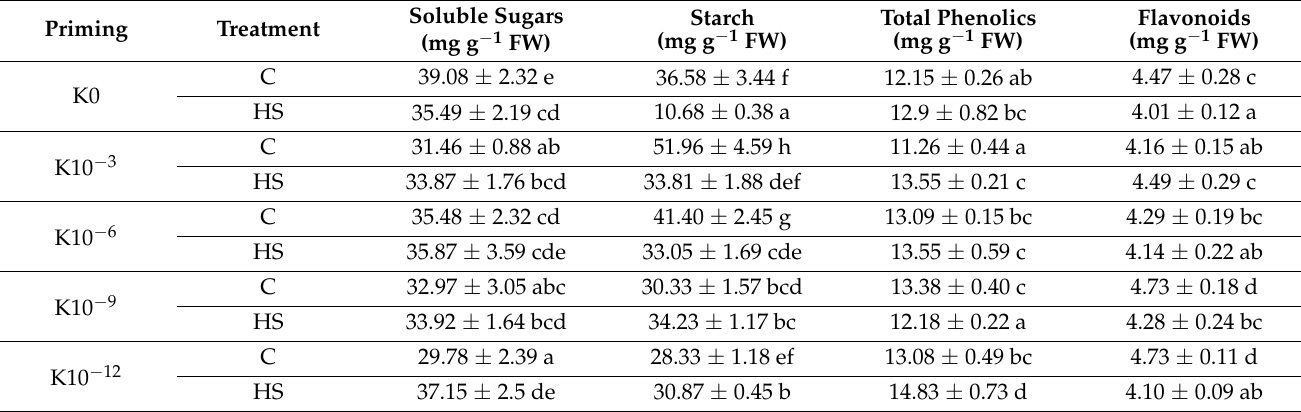
Figure 2. Photosynthetic pigments ( A ), free L-Pro content ( B ), and MDA ( C ) in soil-grown maize plants subjected to heat waves with or without biostimulant treatment (application via foliar spray of 10 − 3 , 10 − 6 , 10 − 9 , and 10 − 12 Kaishi solution). Values are means of three biological repeats ( n = 3) ± SD. Different lowercase letters (multifactor ANOVA) and asterisks (one-way ANOVA) indicate statistically significant differences at p < 0.05. Table 2. Content of soluble sugars and starch (as glucose equivalents), total phenolics (as caffeic acid equivalents), and flavonoids (as rutin equivalents) in the leaves of Kaishi-pre-treated (K) and non-primed plants (K0) under control conditions (C) and subjected to heat stress (HS). Values are mean ± standard deviation from three replicates. Different lowercase letters indicate statistically significant differences at p < 0.05 (multifactor